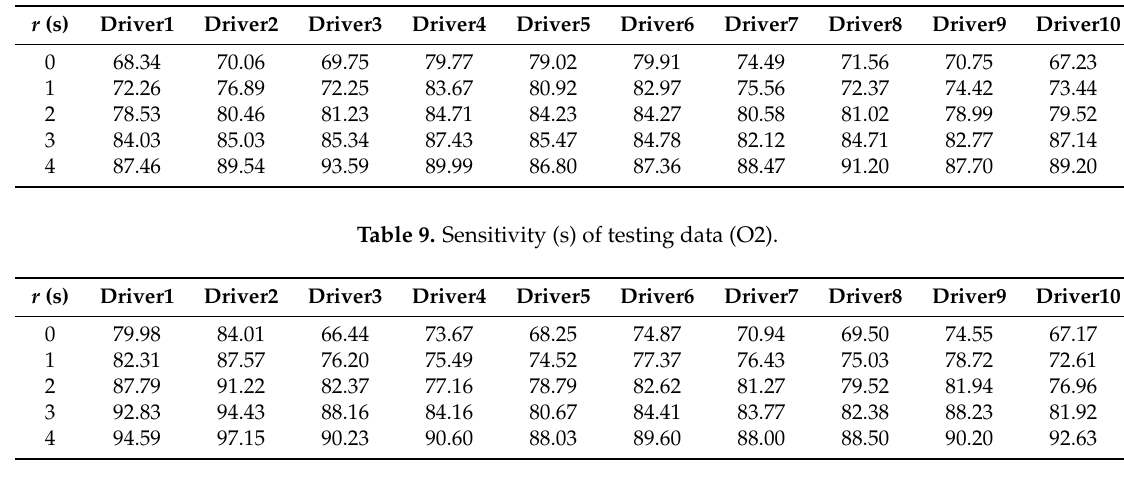
Table 10. False positives (s) of testing data (O1).